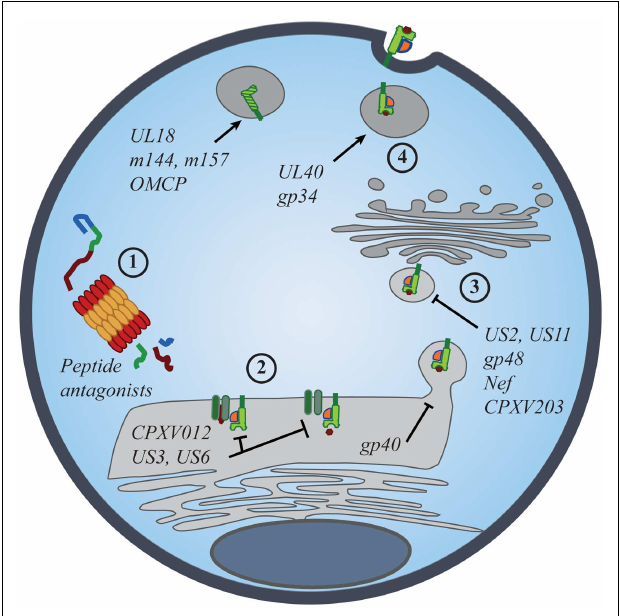
FIGURE 2 |Viral manipulation of the MHC class I antigen processing and presentation .The presentation of self- and foreign-peptides on MHC class I molecules is integral to the regulation of both NK and CD8 + T cell immunity.Viruses have developed multiple strategies to interfere with class I antigen presentation, with the ultimate goal of evading both innate and adaptive immune recognition. Manipulation of class I molecules can occur at various stages of the class I expression pathway: (1) peptide antagonists produced during proteasomal degradation of cytoplasmic proteins dictate the affinity of class I interactions with iNKR and CD8 + TCR; (2) immunoevasins interfere with the proper loading and folding of the class I molecules, and even retain properly folded molecules in the ER; (3) viral proteins promote the export of class I molecules into the cytosol for proteasomal degradation or re-direct class I trafficking from the ER to endo-lysosomal compartments; (4) viral proteins promote the expression of classical and non-classical MHC molecules, as well as class I mimics, to specifically inhibit NK-cell